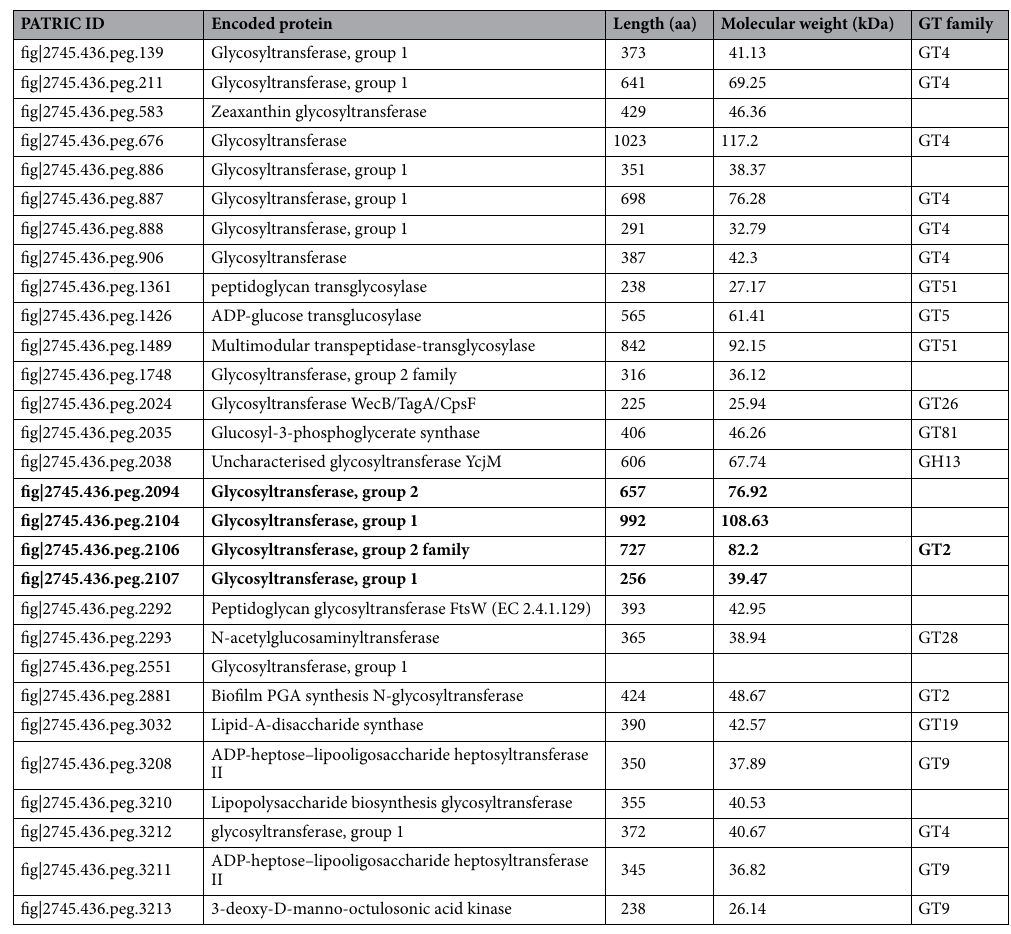
fig|2745.436.peg.139 Glycosyltransferase, group 1 fig|2745.436.peg.211 Glycosyltransferase, group 1 fig|2745.436.peg.583 Zeaxanthin glycosyltransferase fig|2745.436.peg.676 Glycosyltransferase fig|2745.436.peg.886 Glycosyltransferase, group 1 fig|2745.436.peg.887 Glycosyltransferase, group 1 fig|2745.436.peg.888 Glycosyltransferase, group 1 fig|2745.436.peg.906 Glycosyltransferase fig|2745.436.peg.1361 peptidoglycan transglycosylase fig|2745.436.peg.1426 ADP-glucose transglucosylase fig|2745.436.peg.1489 Multimodular transpeptidase-transglycosylase fig|2745.436.peg.1748 Glycosyltransferase, group 2 family fig|2745.436.peg.2024 Glycosyltransferase WecB/TagA/CpsF fig|2745.436.peg.2035 Glucosyl-3-phosphoglycerate synthase fig|2745.436.peg.2038 Uncharacterised glycosyltransferase YcjM fig|2745.436.peg.2094 Glycosyltransferase, group 2 fig|2745.436.peg.2104 Glycosyltransferase, group 1 fig|2745.436.peg.2106 Glycosyltransferase, group 2 family fig|2745.436.peg.2107 Glycosyltransferase, group 1 fig|2745.436.peg.2292 Peptidoglycan glycosyltransferase FtsW (EC 2.4.1.129) fig|2745.436.peg.2293 N-acetylglucosaminyltransferase fig|2745.436.peg.2551 Glycosyltransferase, group 1 fig|2745.436.peg.2881 Biofilm PGA synthesis N-glycosyltransferase fig|2745.436.peg.3032 fig|2745.436.peg.3208 ADP-heptose–lipooligosaccharide heptosyltransferase II fig|2745.436.peg.3210 Lipopolysaccharide biosynthesis glycosyltransferase fig|2745.436.peg.3212 glycosyltransferase, group 1 fig|2745.436.peg.3211 ADP-heptose–lipooligosaccharide heptosyltransferase II Table 4. Glycosyltransferases present in H. malpeensis YU-PRIM-29 T genome. The GT’s in bold are the glycosyl transferases identified in the EPS gene cluster.